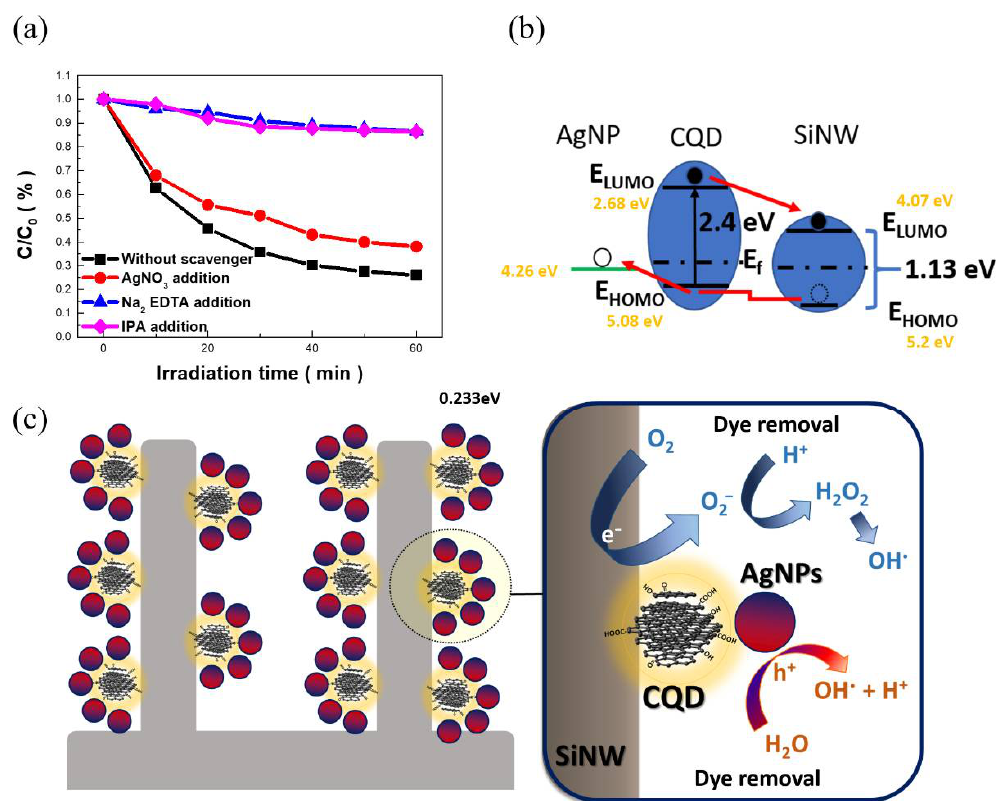
Figure 5. ( a ) Scvenger examinations of photodegradation process using CQD/AgNP@SiNWs as photocatalysts. ( b ) Corre- lated band diagram of hybrid heterostructures. ( c ) Possible mechanism of photodegradation of MB dyes. Table 1. Measured results of zeta potential and contact angles of various photocatalysts.